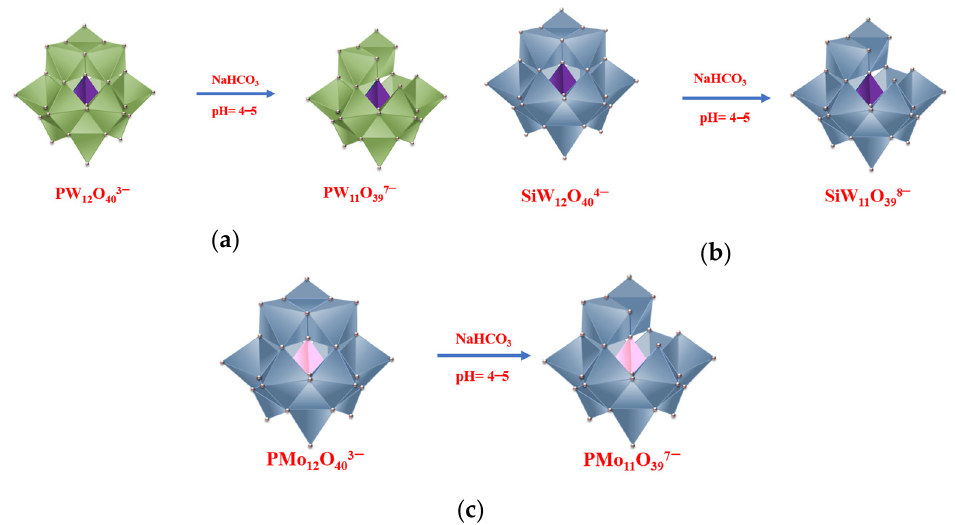
Scheme 2. Synthesis of phosphotungstic ( a ), silicotungstic ( b ), and phosphomolybdic acid ( c ) lacu-